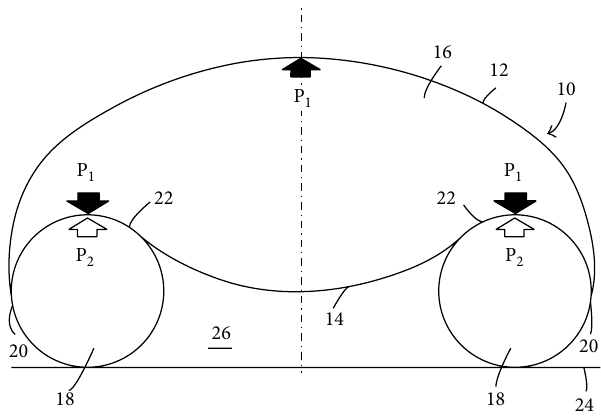
Figure 11: Construction method invented by Prouvost with two air chambers to avoid the need for fixations at the circumference [15].